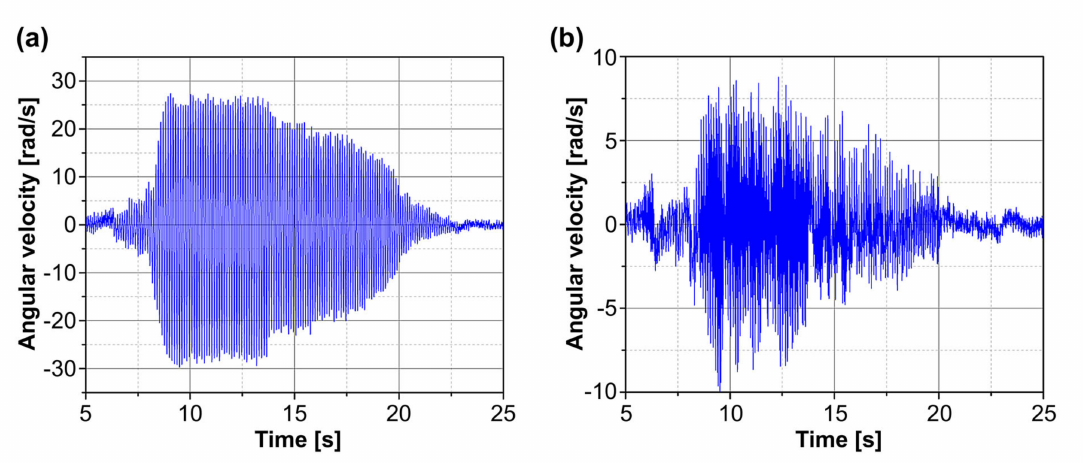
Figure 8. Timedomainofangularvelocityatflexiblecouplingduringaccelerationinrangeof600–800r / min ( a ) Engine side; ( b ) Shaft